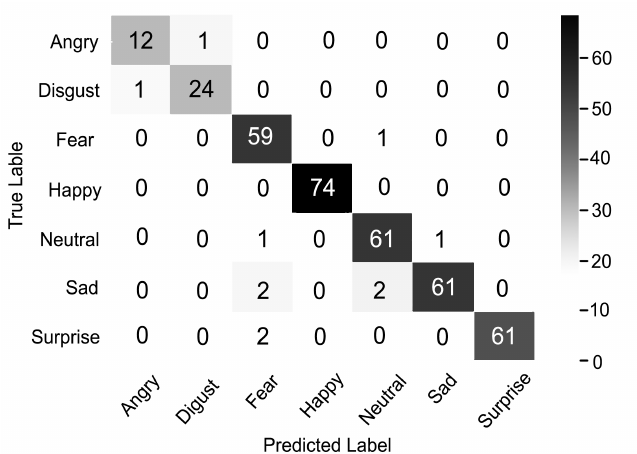
Figure 6. Confusion matrix of seven emotions with RIA-DCNN facial expression